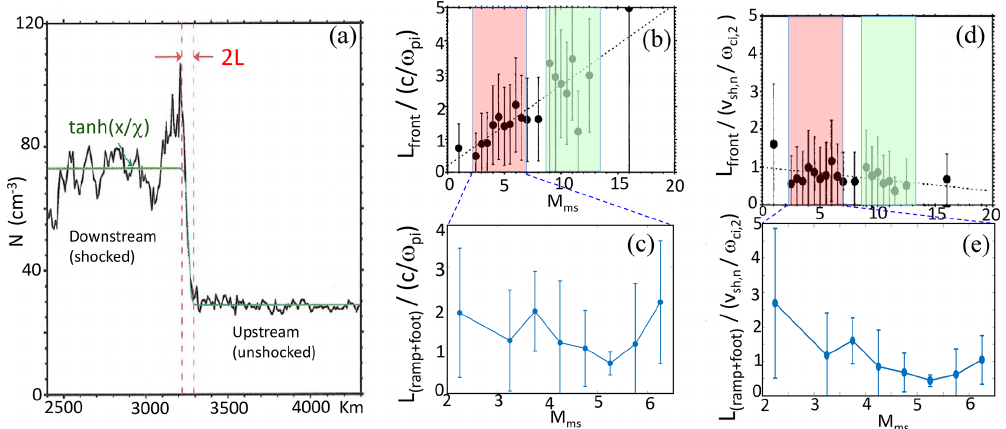
Figure 12. Panels (a) , (b) , and (d) are issued from Figs. 3 and 6 of Bale et al. (2003) for the shock crossing on 15 December 2000 at 01:26:15, while (c) and (e) are similar to (b) and (d) but correspond to results from the present analysis. Panel (c) has to be compared with an enlarged view of (b) within the magnetosonic Mach number range 2 < M ms < 6 . 5. Panel (a) shows the transition of the density from = 81 ◦ shock (see text), where upstream (unshocked) to downstream (shocked) states for a magnetosonic Mach number M ms = 3 . 5 and θ B n M ms = V sw , sc /c ms with c ms = (c 2 s + v 2 ) 1 / 2 , c s is the sound speed, and V sw , sc is the bulk velocity of solar wind measured in the frame of A the spacecraft; the green line is the hyperbolic tangent fit, and red vertical lines show the density transition scale. In panels (b) and (d) , pink and green areas are superimposed on results by Bale et al. (2003) to indicate, respectively, the same M ms range as for our study and another M ms range (same width) for higher values for comparison. Panel (c) issued from the present results shows the variation of the shock front thickness L ( ramp + foot ) versus the M ms range corresponding to the pink area defined in (b) where L is normalized to the ion inertial length c/ω pi defined upstream. Panel (e) issued from the present results shows the variation of the shock front thickness L ( ramp + foot ) versus M ms for the same range, where L is normalized to ( v sh , n /(cid:127) ci , 2 ) in order to compare with panel (d) , where v sh , n is the shock normal velocity defined in the frame of the solar wind, and (cid:127) ci , 2 is the proton gyrofrequency defined